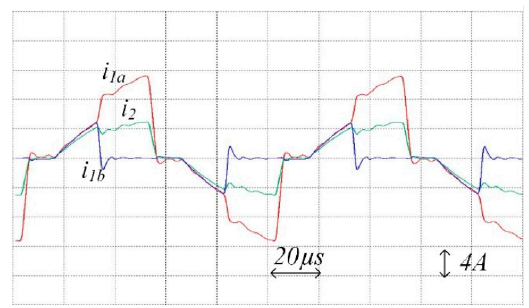
Figure 11. Currents through windings of the proposed system fed from DC supplies with different duty cycles for each